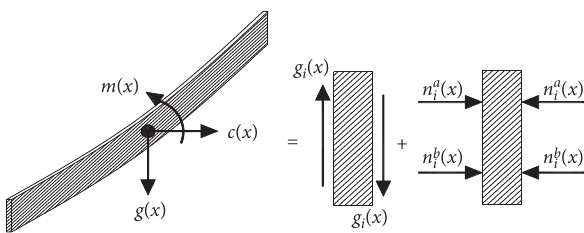
Figure 2: Simplification of the forces at hinge joints.